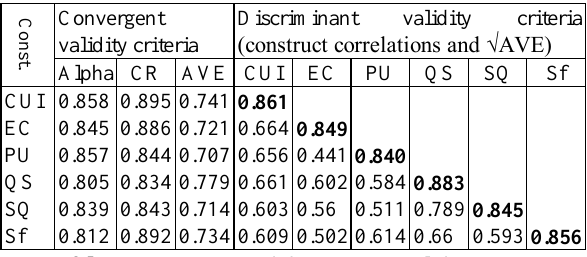
Table 3. Convergent and discriminant validity criteria